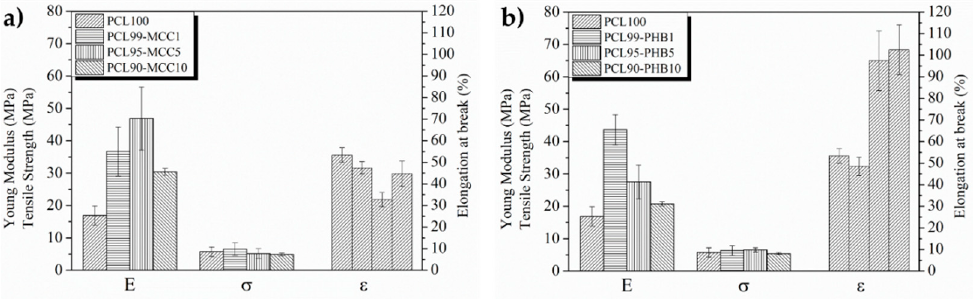
Figure 8. Variation of elastic modulus, tensile strength, and elongation at break for ( a ) PCL-MCC and ( b ) PCL-PHB blends. Table 4. Mechanical response of the di ff erent electrospun blends studied here.